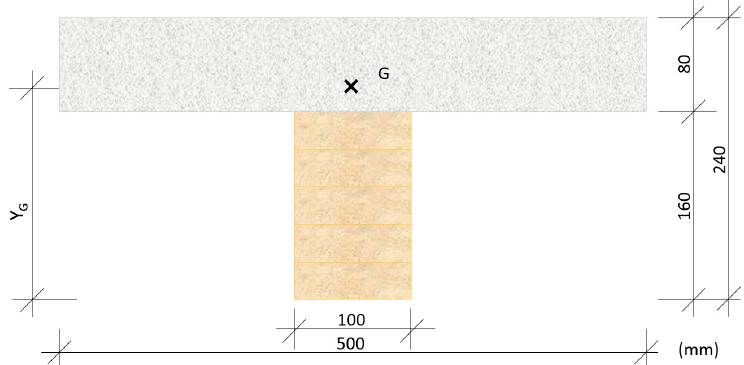
Figure 3. Section of the constructive component.